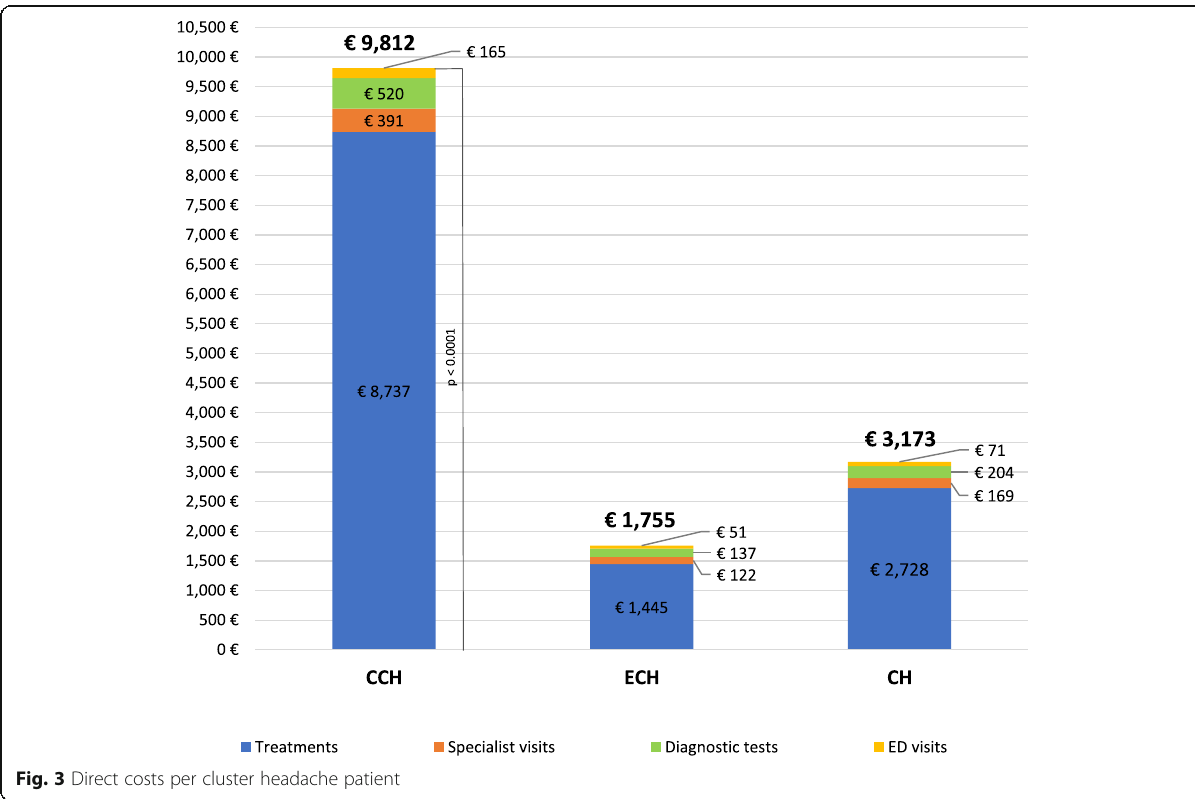
Fig. 3 Direct costs per cluster headache patient